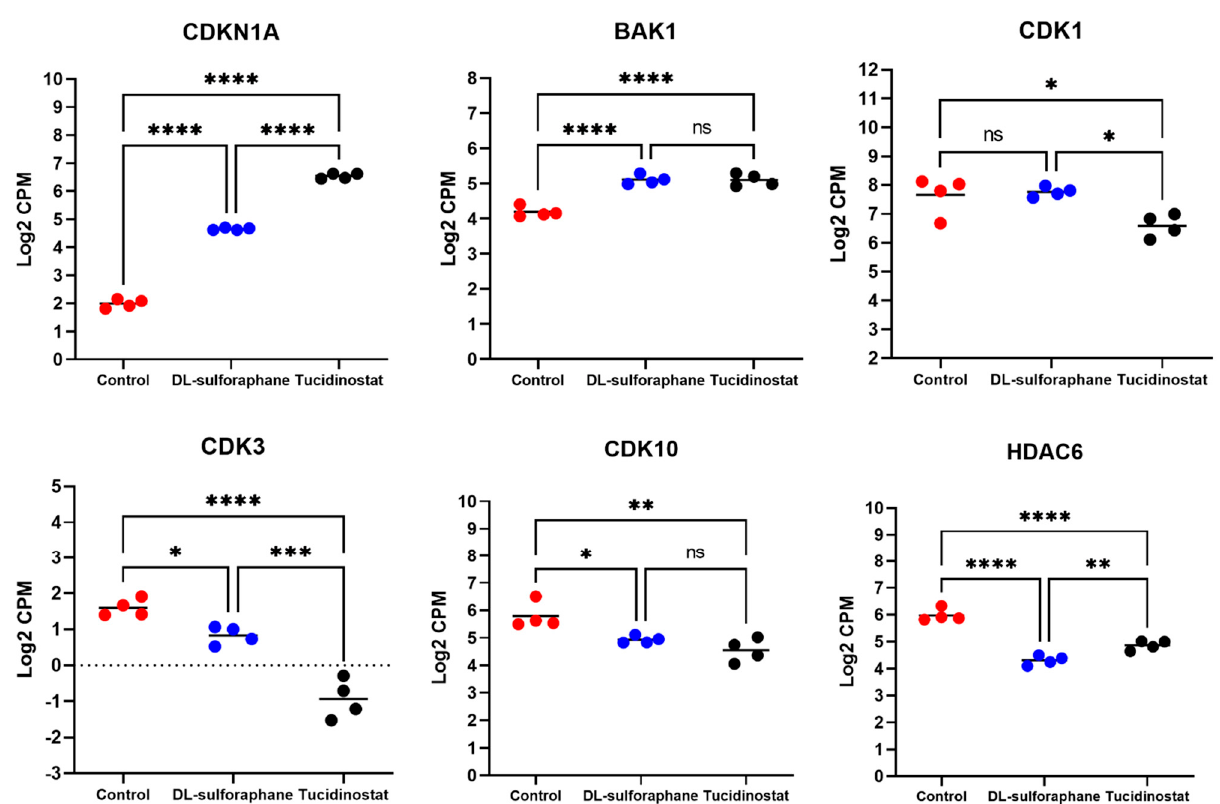
Figure 9. Tucidinostat and DL − sulforaphane altered cell cycle- and apoptosis − related gene expression in uLMS cells. RNA − seq revealed the upregulation of P21 and BAK1 and downregulation of CDK1, CDK3, CDK10, and HDAC6 in uLMS cells. NS: no significant difference; * p < 0.05; ** p < 0.01; *** p < 0.001; **** p < 0.0001.